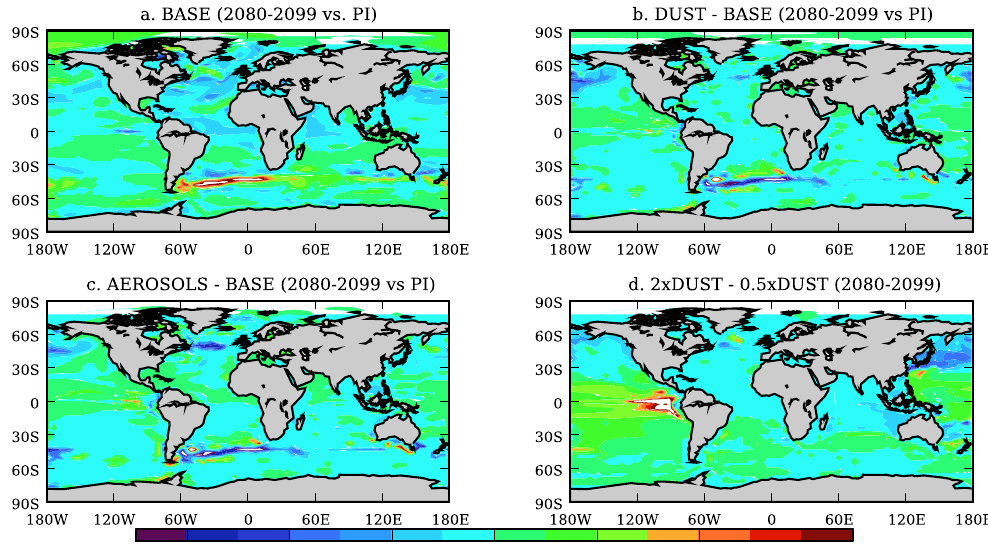
Fig. 15. Same as Fig. 11 but for the total chlorophyll (mg Chlm − 3 ) in the mixed layer.